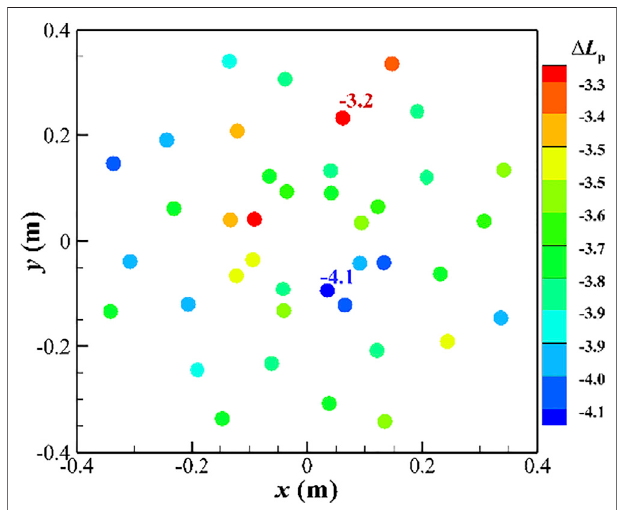
FIGURE 9 | Difference in OASPL ( fi ltered between 50 and 6,000 Hz) of the propeller at 5,100 r/min in the acoustic array.